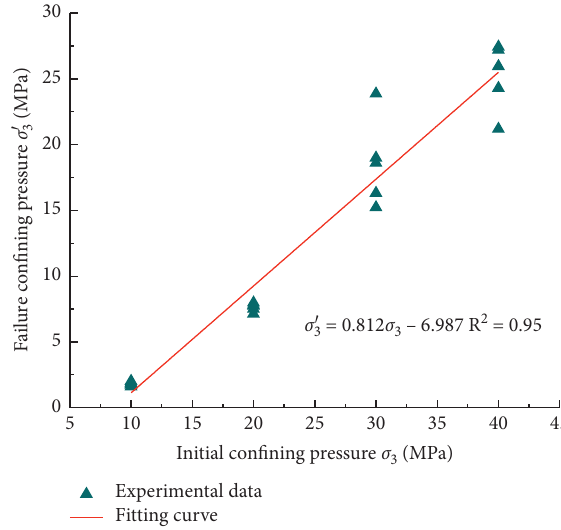
Figure 7: Relationship between initial confining pressure and failure confining